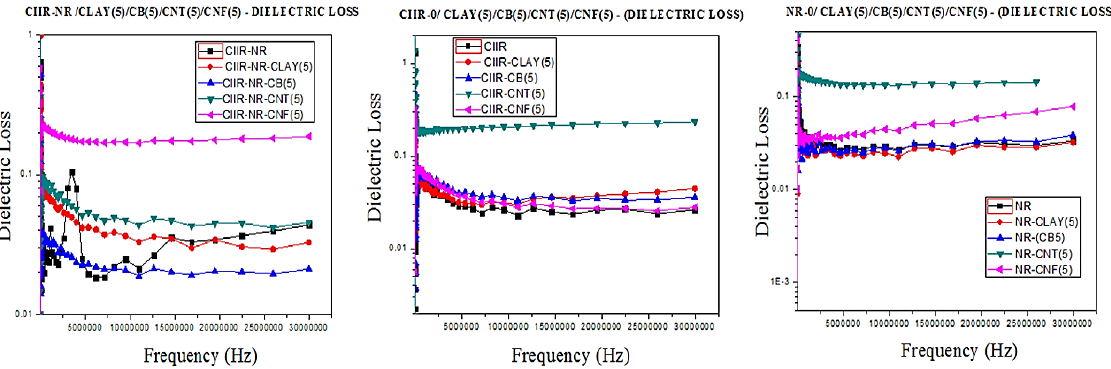
Figure 14. Frequency dependencies of dielectric permittivity of CIIR/NR blend, CIIR and NR rubber nanocomposites with different fillers.